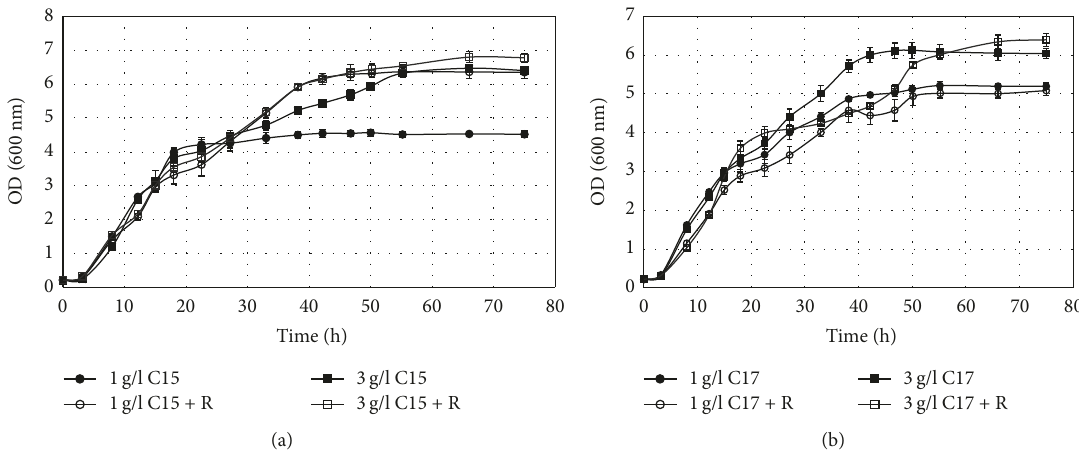
Figure 2: Growth curves of Y. lipolytica CCY 30-26-36 on pentadecane (a) and heptadecane (b) as a sole carbon source (R = addition of